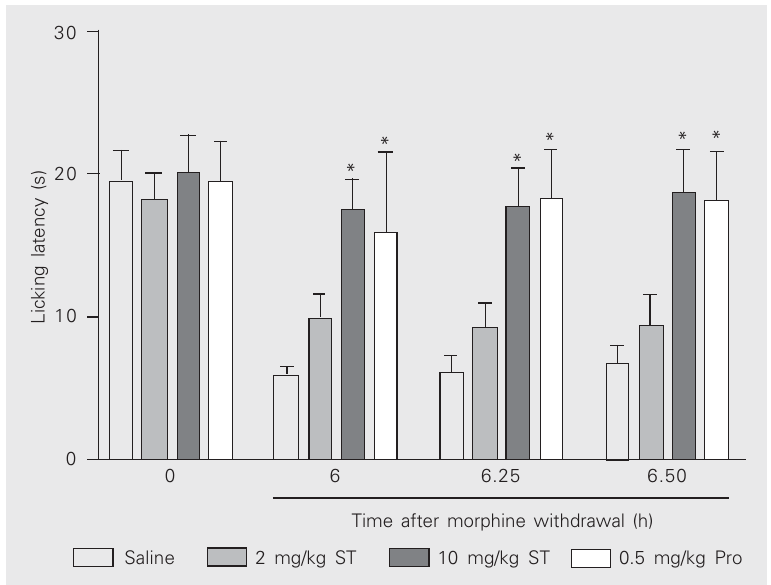
Figure 1. Effect of Sapindus trifoliatus (ST) extract at 2 and 10 mg/kg, ip , on morphine withdrawal hyperalgesia. Each column indicates the mean ± SEM, in seconds, of the hot- plate licking latency for 10 mice. Pro = prochlorperazine. *P < 0.05 compared with saline- treated animals (ANOVA followed by Dunnetts’